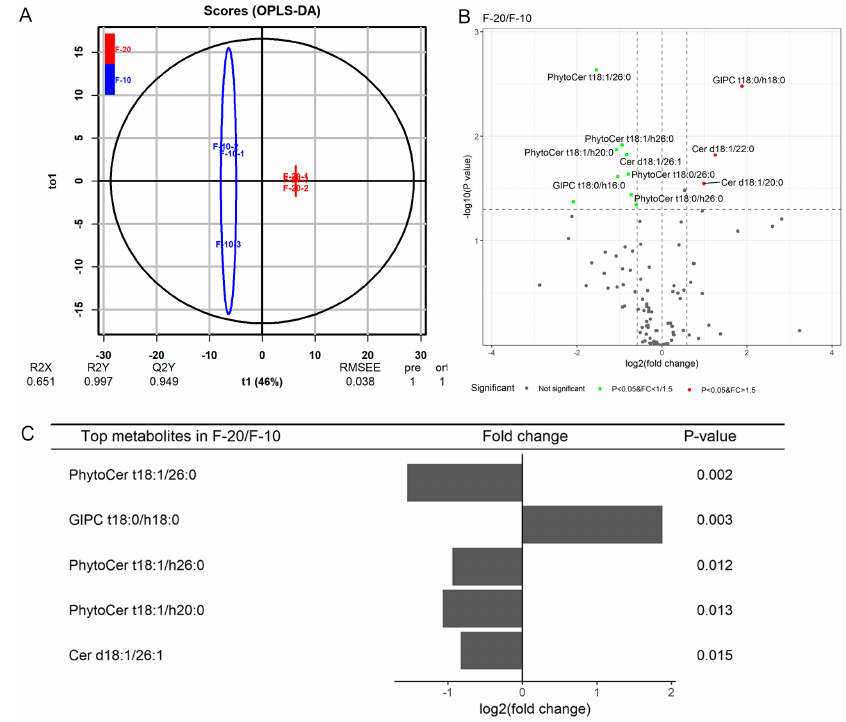
Figure 4. Differences in sphingolipids species in fiber cells between 10 DPA and 20 DPA. ( A ) The OPLS-DA score plot between the 10 DPA group and the 20 DPA group. ( B ) Volcano map of sphingolipid molecular species in fiber cells between 10 DPA and 20 DPA. ( C ) The fold changes of